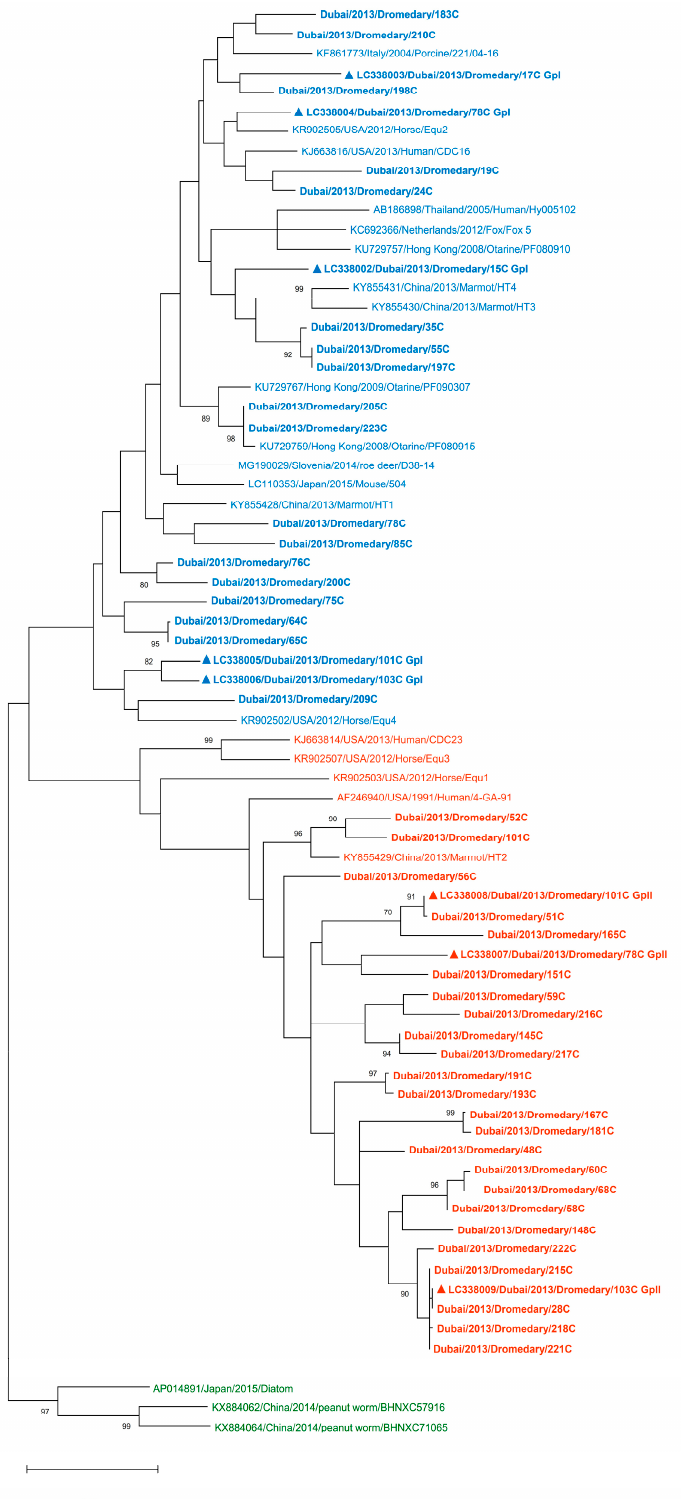
Figure 1. Phylogenetic analysis of the RdRp of genogroup I and genogroup II PBVs and their relationship with other genogroup I, II, and III PBV sequences. Sequences that did not display nucleotide polymorphisms (50 out of 121 PBV-positive samples detected from a screening of 229 dromedary fecal samples) were selected for phylogenetic analysis. The tree was constructed using the maximum likelihood method and is based on the nucleotide of a 205 bp RdRp fragment of segment 2. Numbers at nodes indicated level of bootstrap support calculated from 1000 replicates; bootstrap values below 70% are not shown, and the scale bar indicates the number of nucleotide